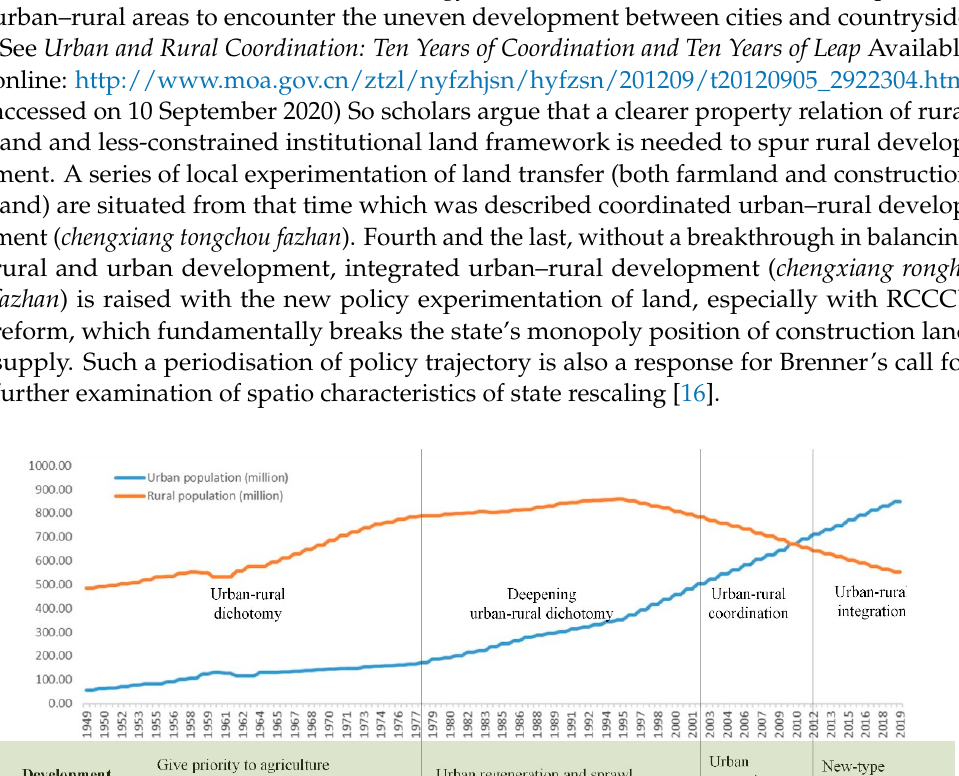
Figure 6. The interaction of three relations.